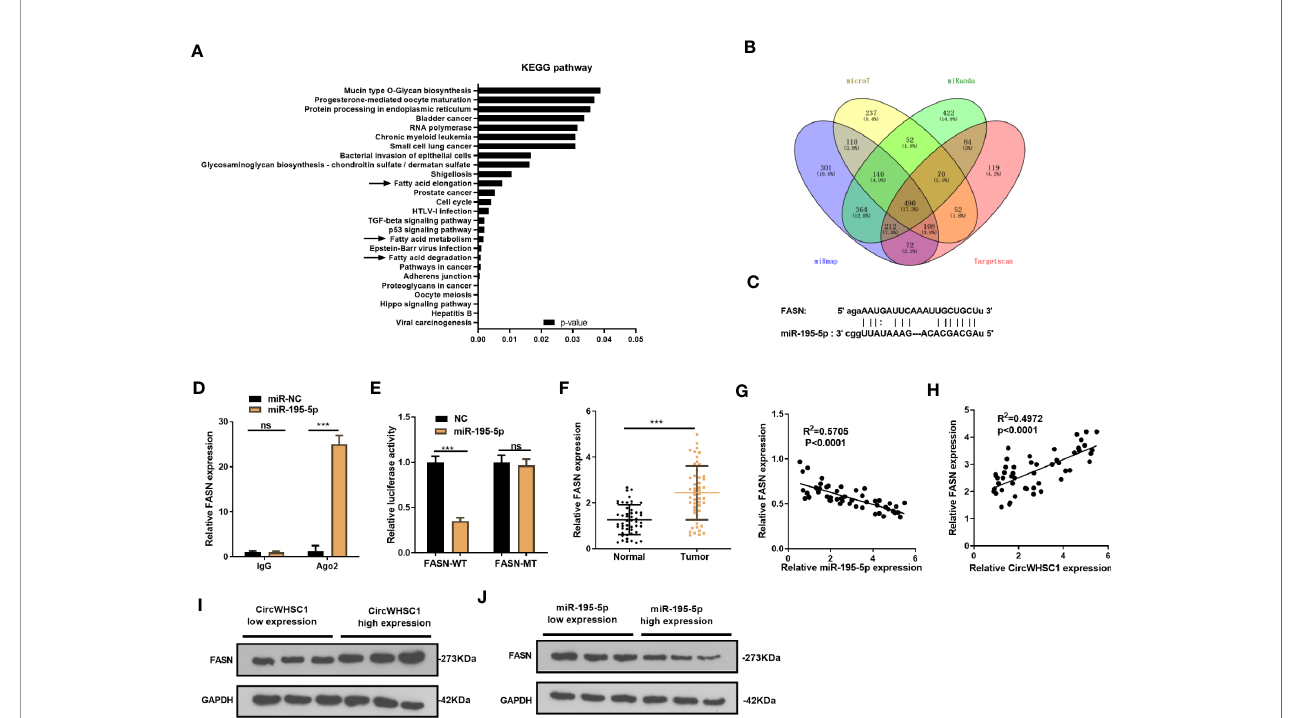
FIGURE 6 | FASN was targeted by miR-195-5p. (A) . miRpath was employed to analyze the related pathways modulated by miR-195-5p. (B) Venn Diagram was utilized to investigate the candidate targets of miR-195-5p among four databases (including microT, Targetscan, miRanda and miRmap). (C) The binding sites of the 3 ’ UTR of FASN mRNA with miR-195-5p. (D) RIP assay tested the targeting association between miR-195-5p and FASN. (E) The dual-luciferase reporter gene assay detected the binding of FASN with miR-195-5p. (F) qRT-PCR tested the FASN mRNA level in BC tissues. (G, H) Pearson linear regression analysis revealed that FASN mRNA was negatively related to miR-195-5p expression (G) and positively correlated with the circWHSC1 level (H) . (I, J) WB was conducted to detect FASN in BC tissues with different levels of circWHSC1 (I) or miR-195-5p (J) . ns P > 0.05, *** P < 0.001. N=3.